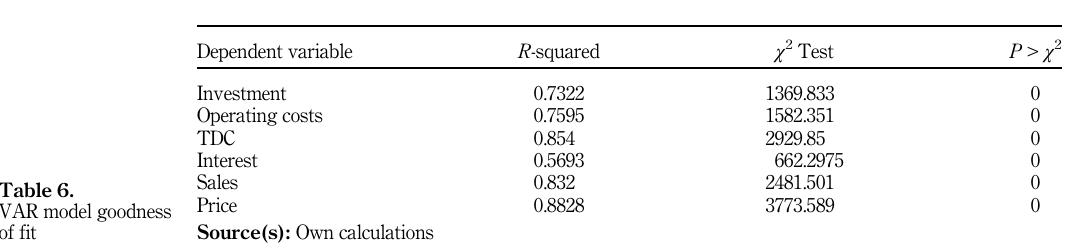
Table 5. Results of the Akaike information criterion (AIC) test